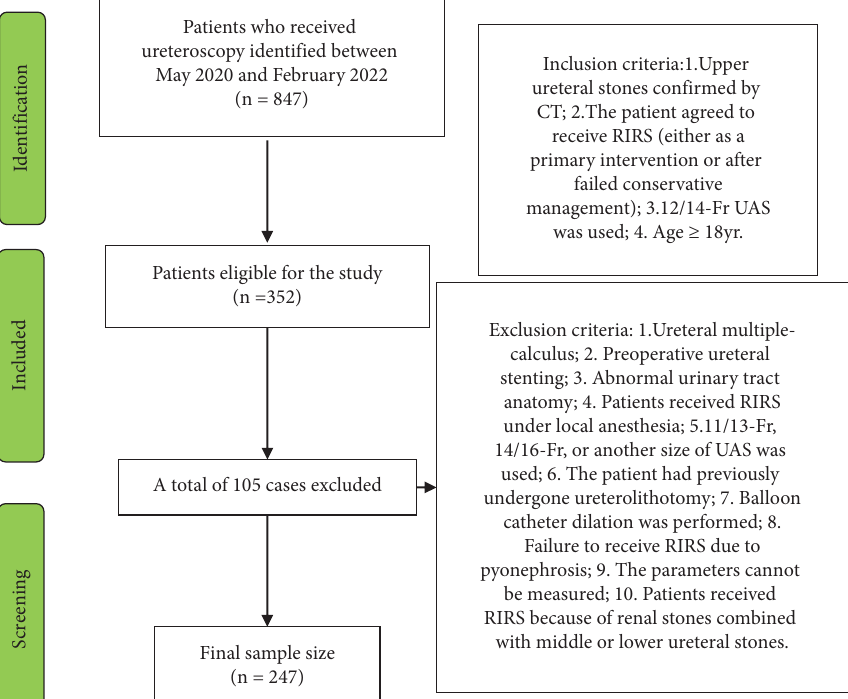
Figure 1: Flow diagram of the patient